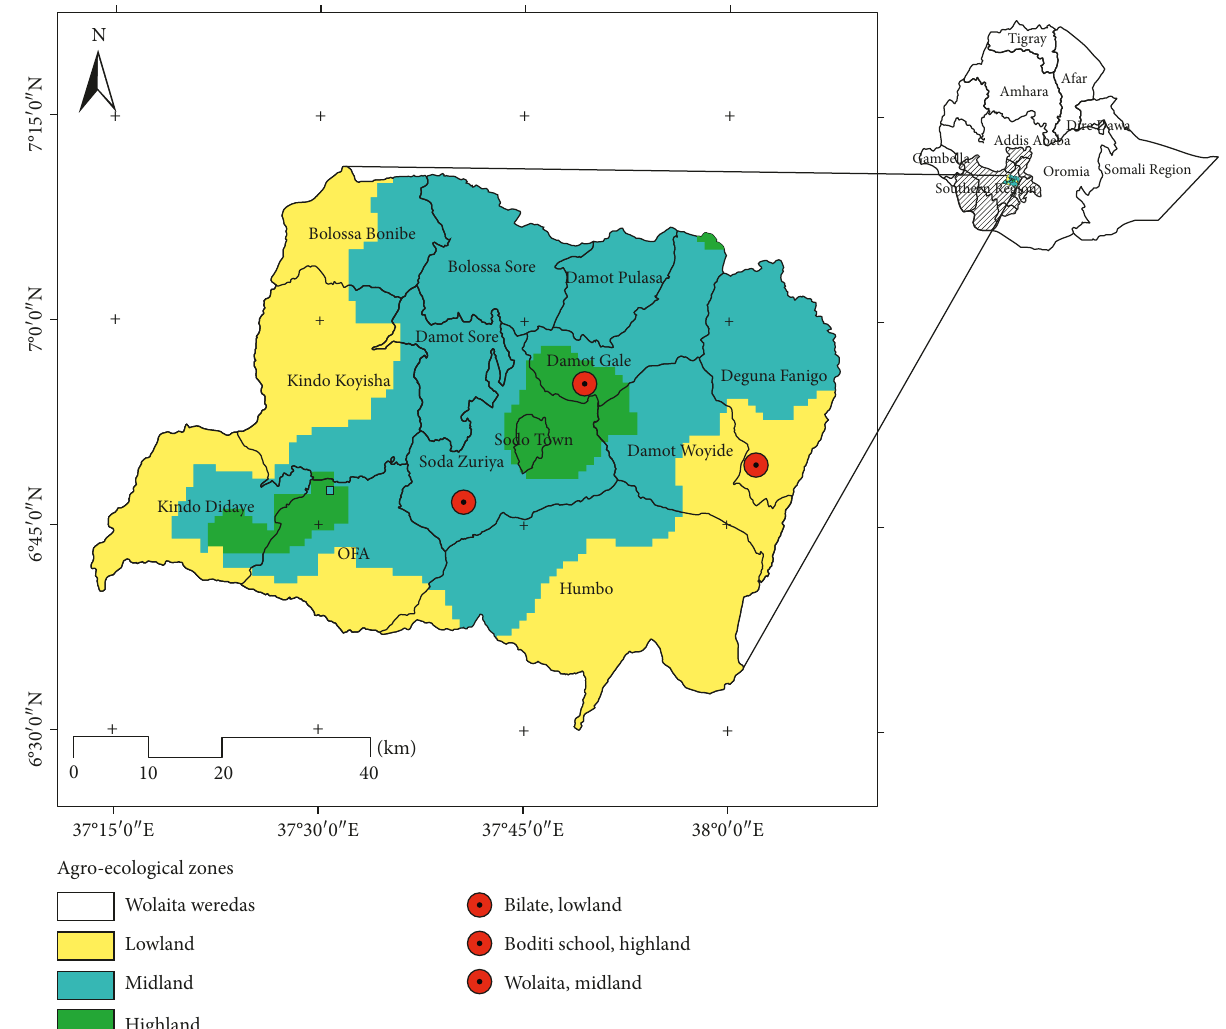
Figure 1: Location of agroecological zones.